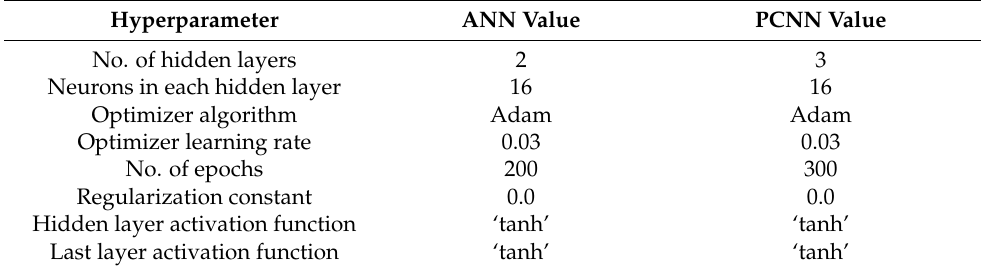
Table 2. Values of hyperparameters used for the three ANN models and the